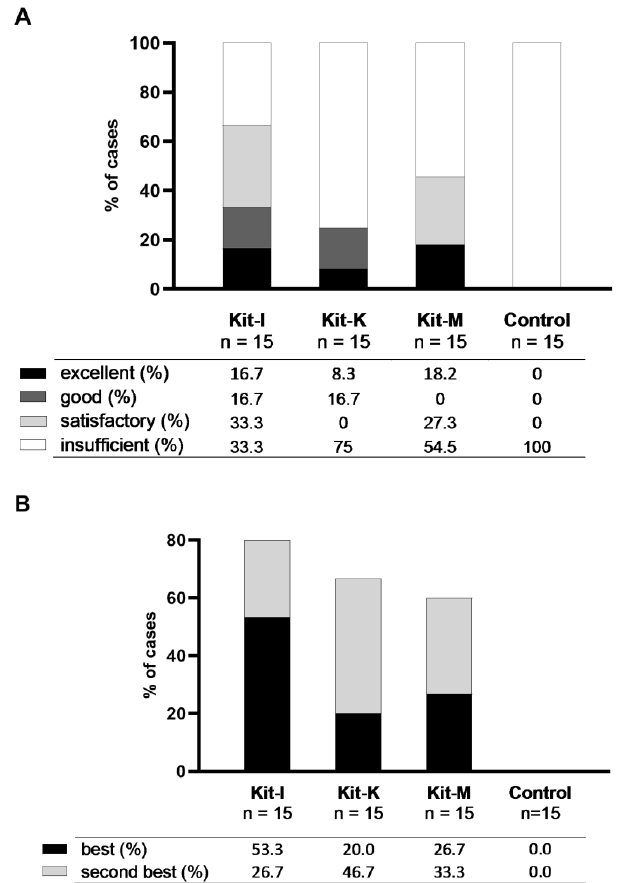
Figure 6. DC/DC leu -generation from leukaemic WB with Kit-I, -K and -M. Given are the mean ± SD of DC/cells and DC leu /cells generated with Kit-I ( A ), Kit-K ( B ), and Kit-M ( C ) compared to control. Statistically significant differences ( p values < 0.05) (two-tailed t-test) are given.